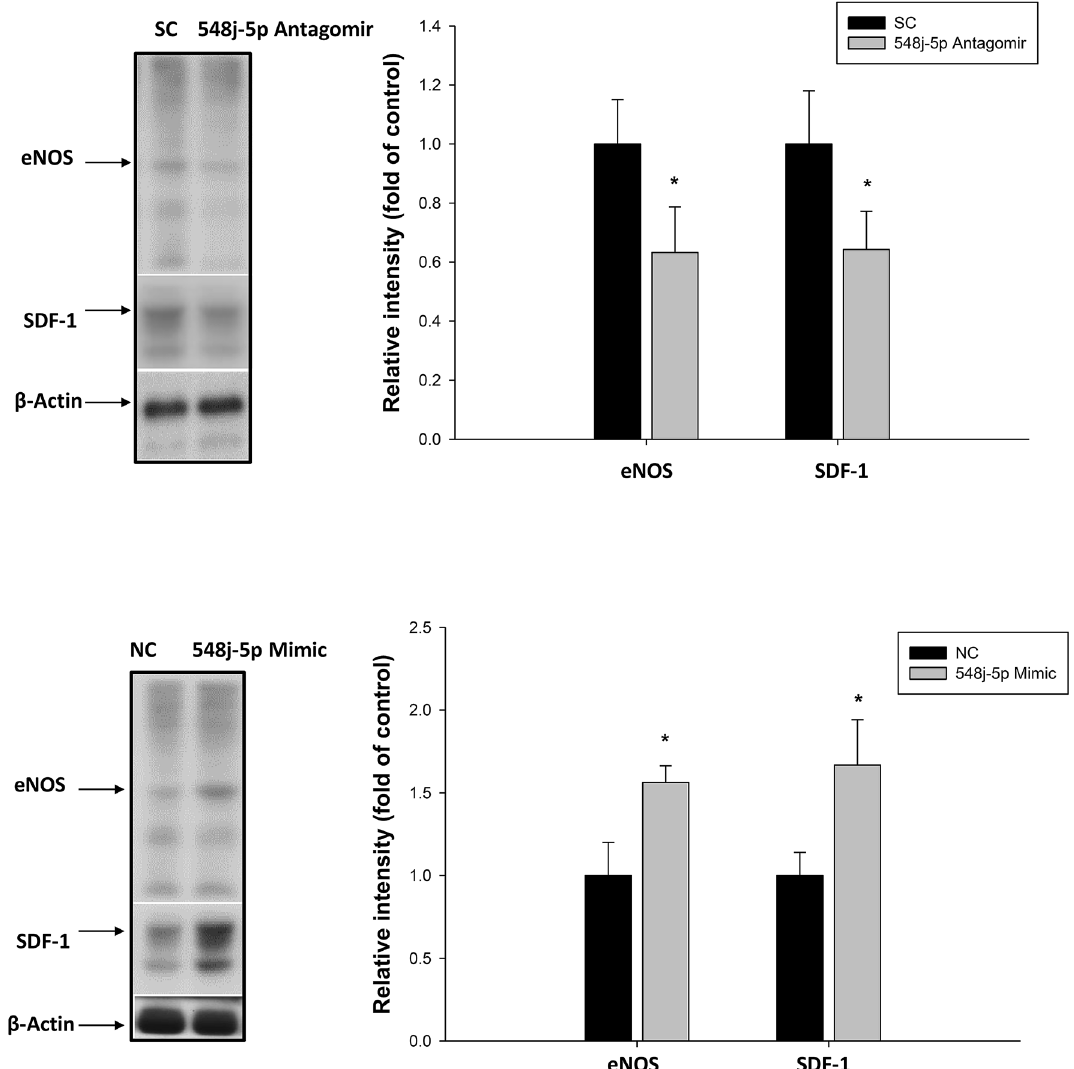
Figure 5. Effects of miR-548j-5p on eNOS and SDF-1 production in EPCs. Impaired expressions of eNOS and SDF-1 were observed in EPCs transfected with miR-548j-5p antagomir as compared with the miR-scramble control (SC). Enhanced expressions of eNOS and SDF-1 were observed in EPCs transfected with miR-548j-5p mimic as compared with the miR-mimic negative control (NC). Data are presented as the mean ± SEM (* P < 0.05 vs. control, n = 6 for each experiment). (Full-length blots/gels are presented in Supplementary Fig.